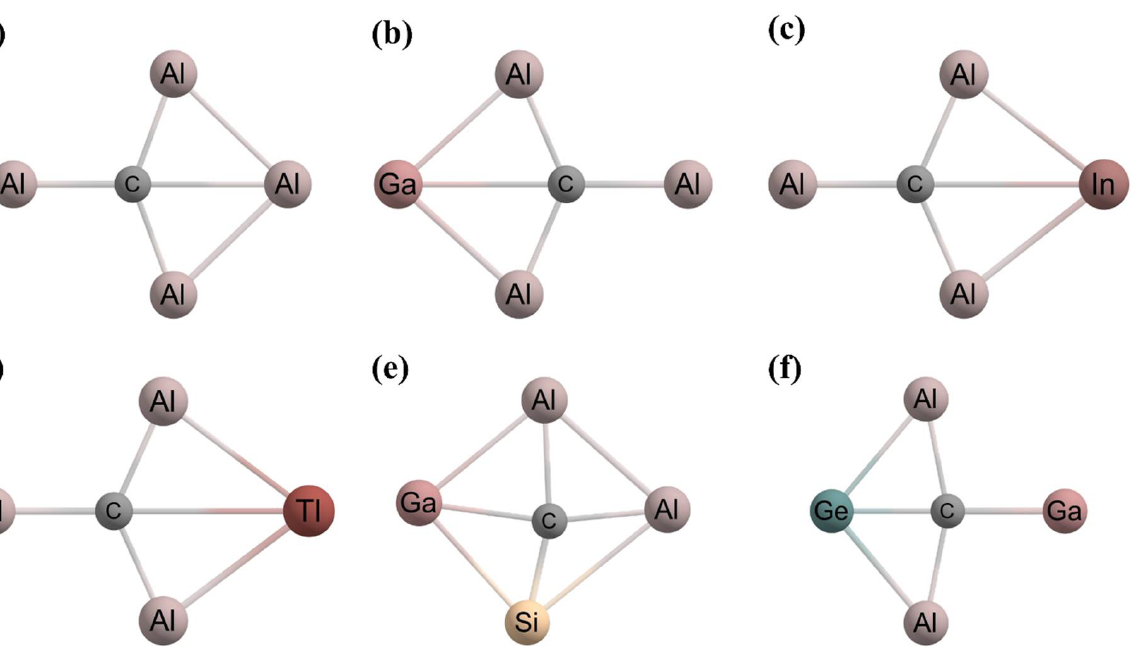
Figure 10. The local minimum structures of ( a ) CAl 4 , ( b ) CAl 3 Ga, and ( c ) CAl 3 In clusters. The global minimum structure of ( d ) CAl 3 Tl, ( e ) CSiGaAl 2 , and ( f ) CGeGaAl 2 clusters with ptCs. Neutral 17-valence electronic CSiGaAl 2 and CGeGaAl 2 clusters were reported by